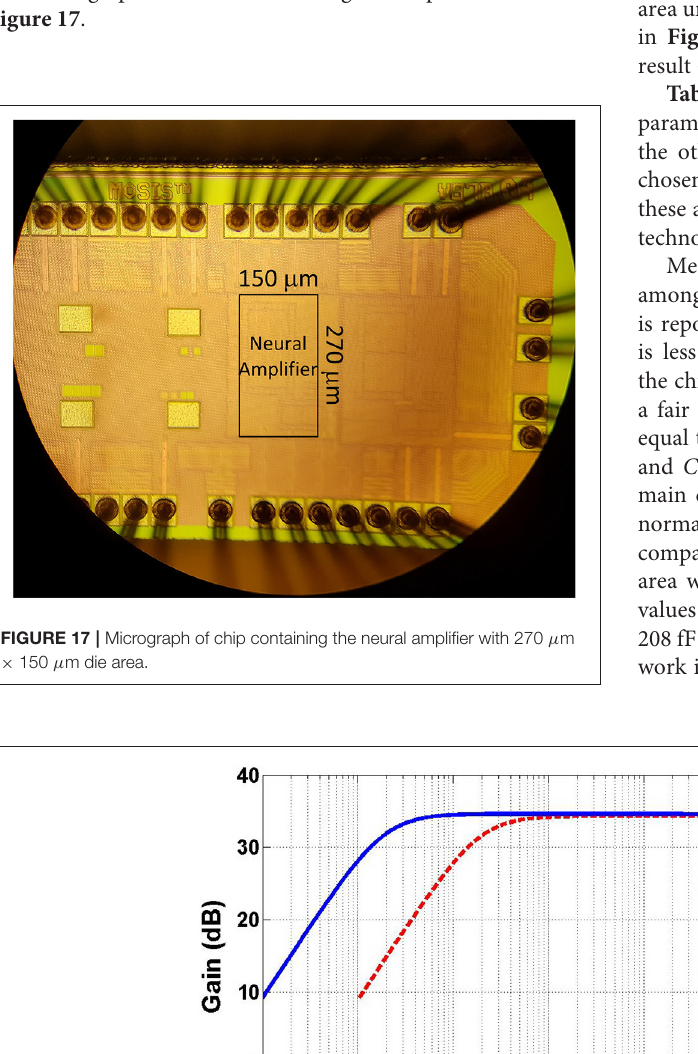
Frontiers in Neuroscience |